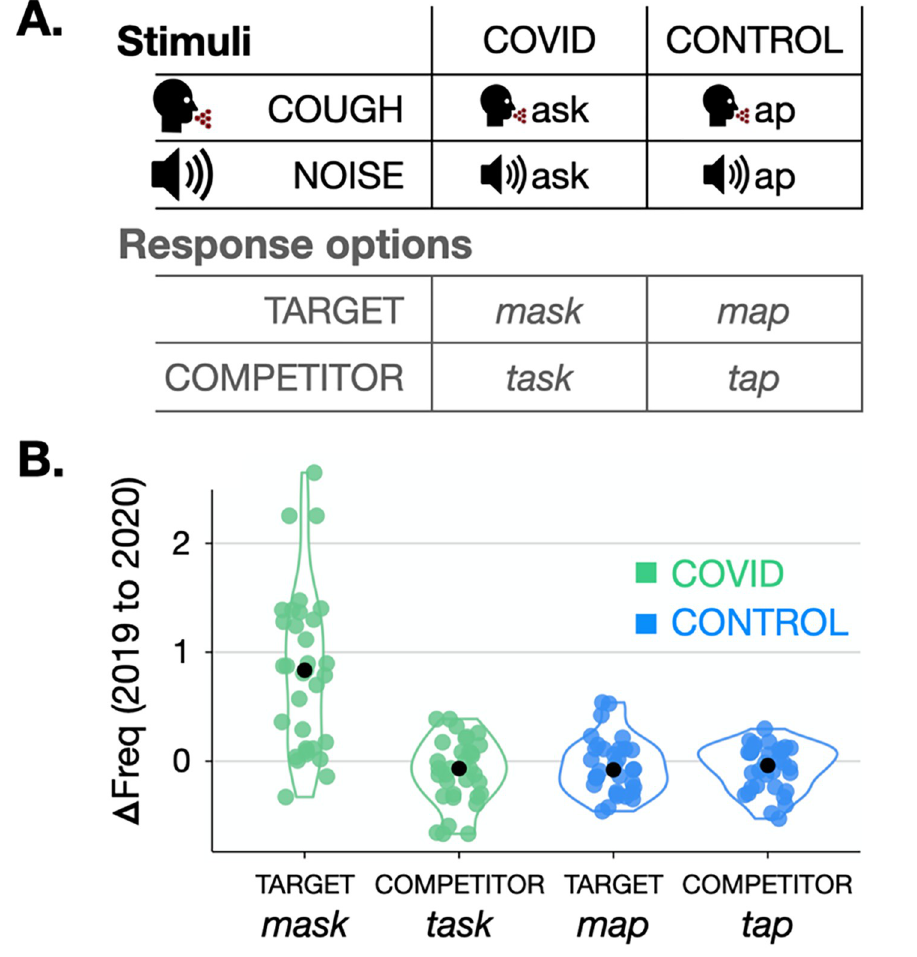
Fig 1. Visualizations of critical stimulus properties. (A) Example stimulus quadruplet. For each COVID/CONTROL pair, the COMPETITOR word was recorded, and the critical sound was removed and replaced with a COUGH or NOISE. Participants’ responses were coded as TARGET or COMPETITOR if they were one of the two pre-defined response options for each stimulus, or otherwise excluded. (B) Changes in stimulus (log) word frequency from 2019 to 2020 by response category. COVID-TARGET words’ frequency increased substantially after the onset of the pandemic ( t (96) = 11.96, p < .001), while the frequencies of other response options remained relatively stable (all | t | < 1.45, all p >